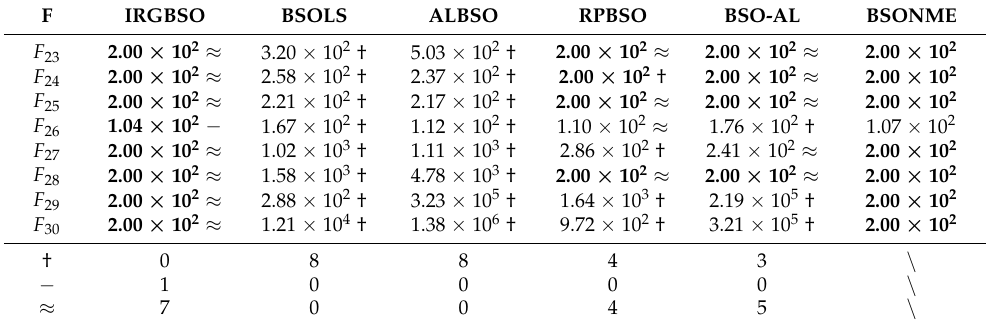
Table 12. Experimental results of IRGBSO, BSOLS, ALBSO, RPBSO, BSO-AL, and BSONME on F 23 – F 30 .